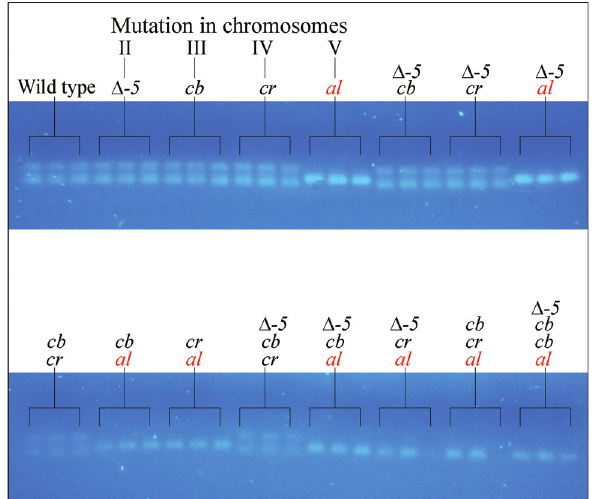
Figure 1 - Sample of 48 backcross offsprings genotyped for Dmed UNICAMP _ssr011 locus (three individuals per phenotype). Mutations Delta-5 ( (cid:2) -5), cabernet ( cb ), coral ( cr )and alfinete ( al ),arelocatedonchro- mosomesII,III,IVandV,respectively.Allthebackcrossoffspringsthatex- press the recessive mutation alfinete (in red) are homozygous for all loci in chromosomeV,suchastheDmed UNICAMP -_ssr011locus.Ontheotherhand, all the backcross offsprings that do not express alfinete are heterozygous for all loci in chromosome V, with different alleles in the parental